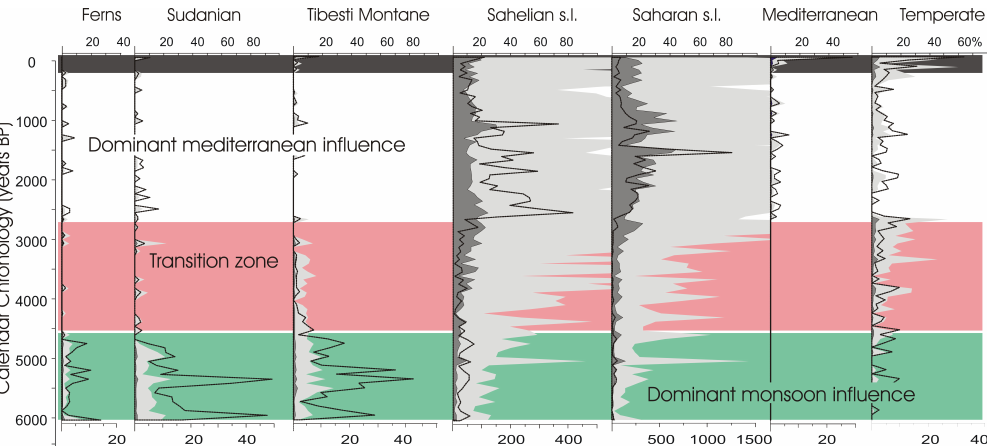
Fig. 8. Lake Yoa main phytogeographical groups. Percentages are indicated in dark grey and magnification (10 times) in light grey. Influxes are shown with dashed black lines. Note that the scales differs for Sahelian (s.l.) and Saharan pollen types which largely dominate the pollen assemblages. This figure shows the main pollen groups corresponding to three main climate regimes which occurred at Yoa from a monsoon dominated climate regime at 6ka to a Mediterranean dominated climate regime at present. Colors refer to Figs. 4 and 5.